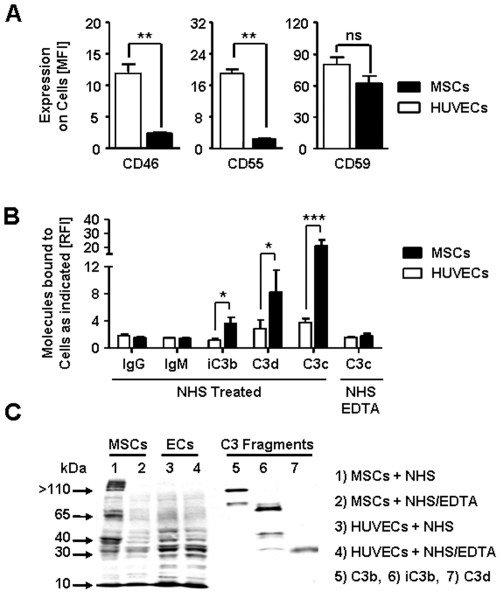
MSCs and ECs differ in their complement regulatory activity.(A) Expression of complement regulatory proteins MCP (CD46), DAF (CD55), and CD59 on MSCs and HUVECs (n = 11 each) was quantified with flow cytometry (MFI, median fluorescence intensity). (B) Cell surface binding of immunoglobulins (IgG and IgM) and specific C3 fragments (iC3b, C3d, C3c) was analyzed after cell treatment with NHS or NHS/EDTA and labeling with specific antibodies directed against the following epitopes: IgG (n = 8), or IgM (n = 8); iC3b (n = 5), C3d (n = 9), C3c (n = 15). (C) Representative western blot for detection of C3c, iC3b and C3d epitopes bound to NHS or NHS/EDTA treated cells. Purified C3b, iC3b and C3d served as positive controls. The data in figure A and B are means±SEM, with: *P<0.05, **P<0.01, ***P<0.001.